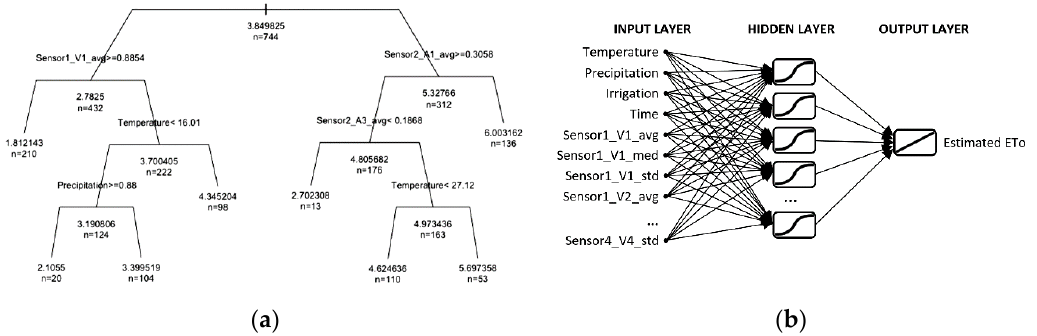
Figure 5. Two of the regression methods studied. ( a ) Trained structure of the regression tree for dataset (iii); in each leaf node, the regression value and the number n of samples is shown. ( b ) Scheme of the artificial neural network designed for dataset (iii).